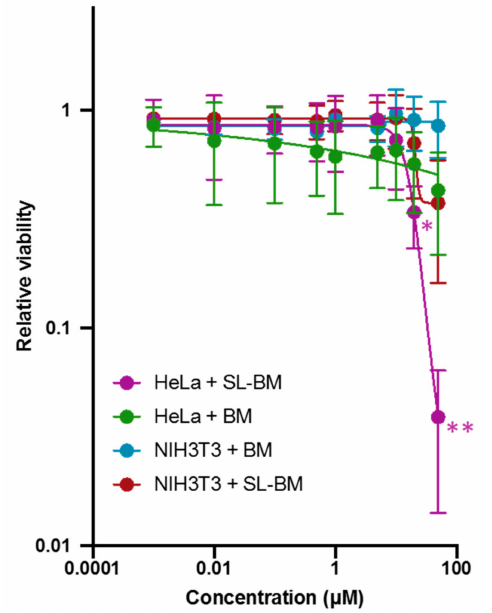
Figure 6. Concentration-dependent cytotoxic e ff ects of BM and SL-BM on NIH3T3 fibroblasts and HeLa carcinoma cells. The cells were treated with BM or SL-BM for 24 h (* p < 0.05, ** p < 0.01). The data points represent the means ± SD ( n =